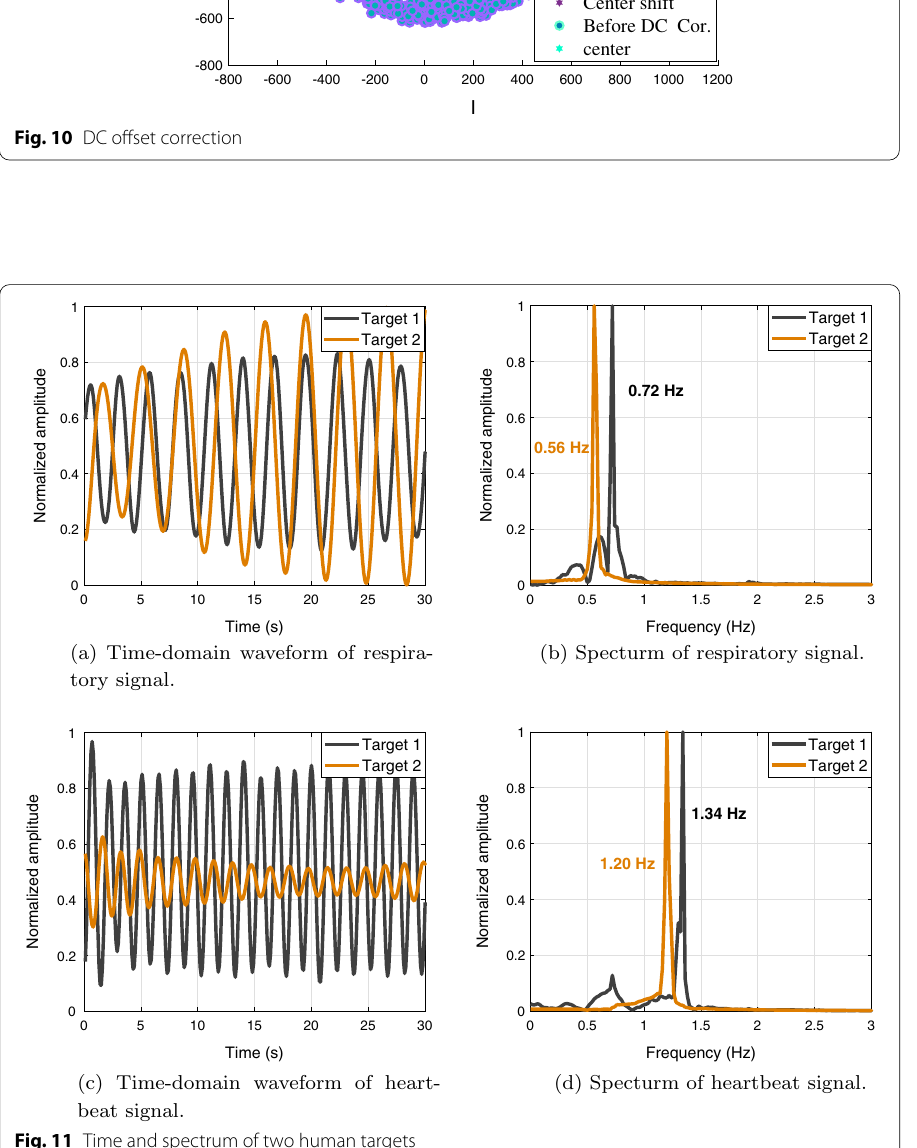
After DC Cor. Center shift Before DC Cor. center